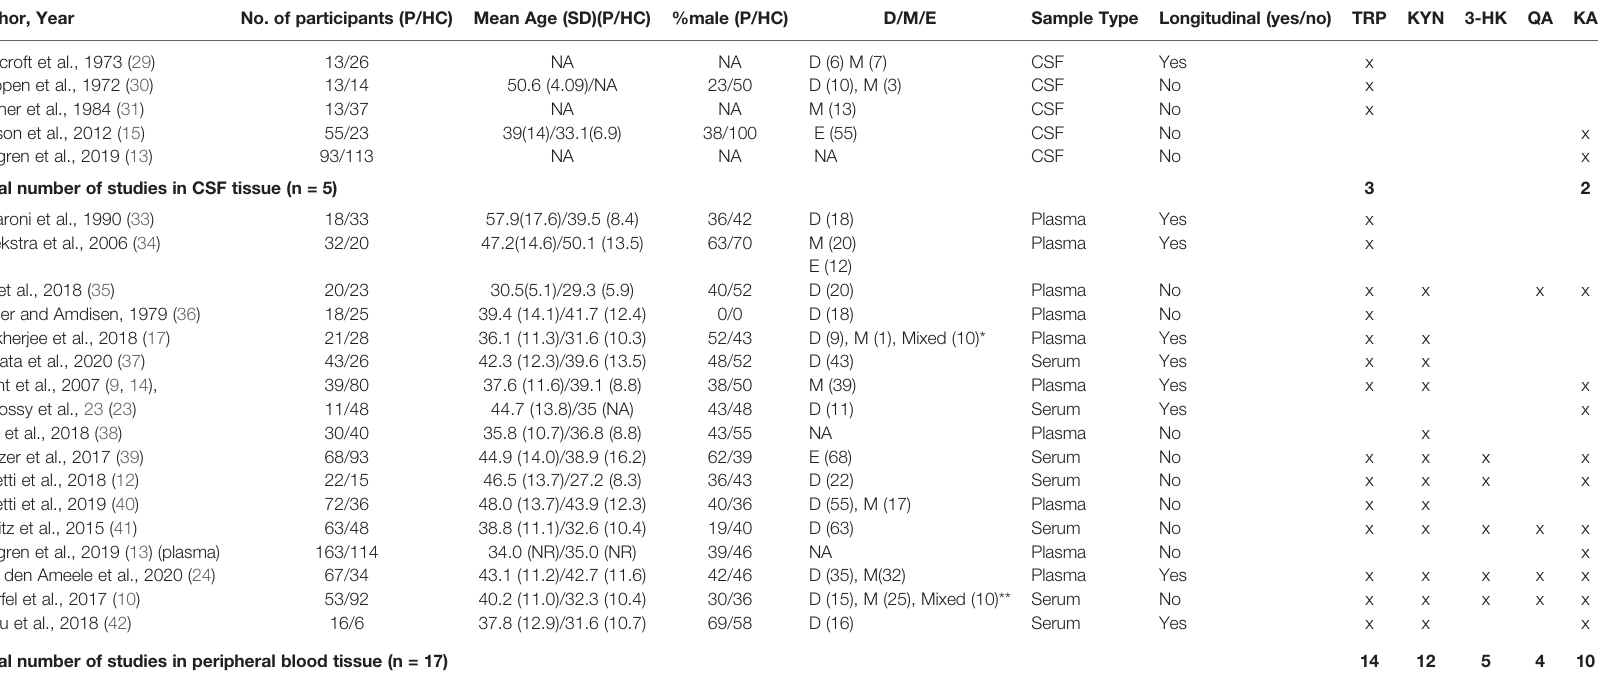
TABLE 1 | Characteristics of included studies. Author,